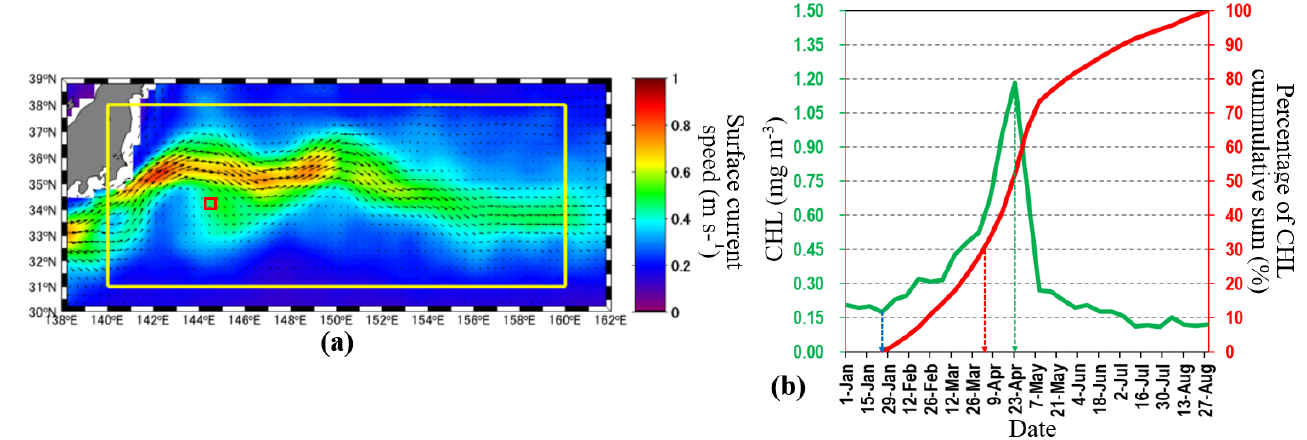
Figure 1. ( a ) Overall mean (1998–2017) ocean surface current map based on Ocean Surface Current Analysis Real-Time data. The yellow box shows the study region. ( b ) Example of data showing a temporal variation of chlorophyll-a concentrations (CHL) (green line) from winter to summer 2001 derived from the station (34°N, 144.5°E) indicated by the red box in ( a ). The red line in ( b ) is the CHL cumulative sum in percentage relative to the maximum cumulative sum of CHL by the end of August. Blue, red, and green dashed arrows in ( b ) indicate the dates of the winter CHL minimum, the onset of the spring bloom (percentage of cumulative sum = 30%), and spring bloom peak, re- spectively.